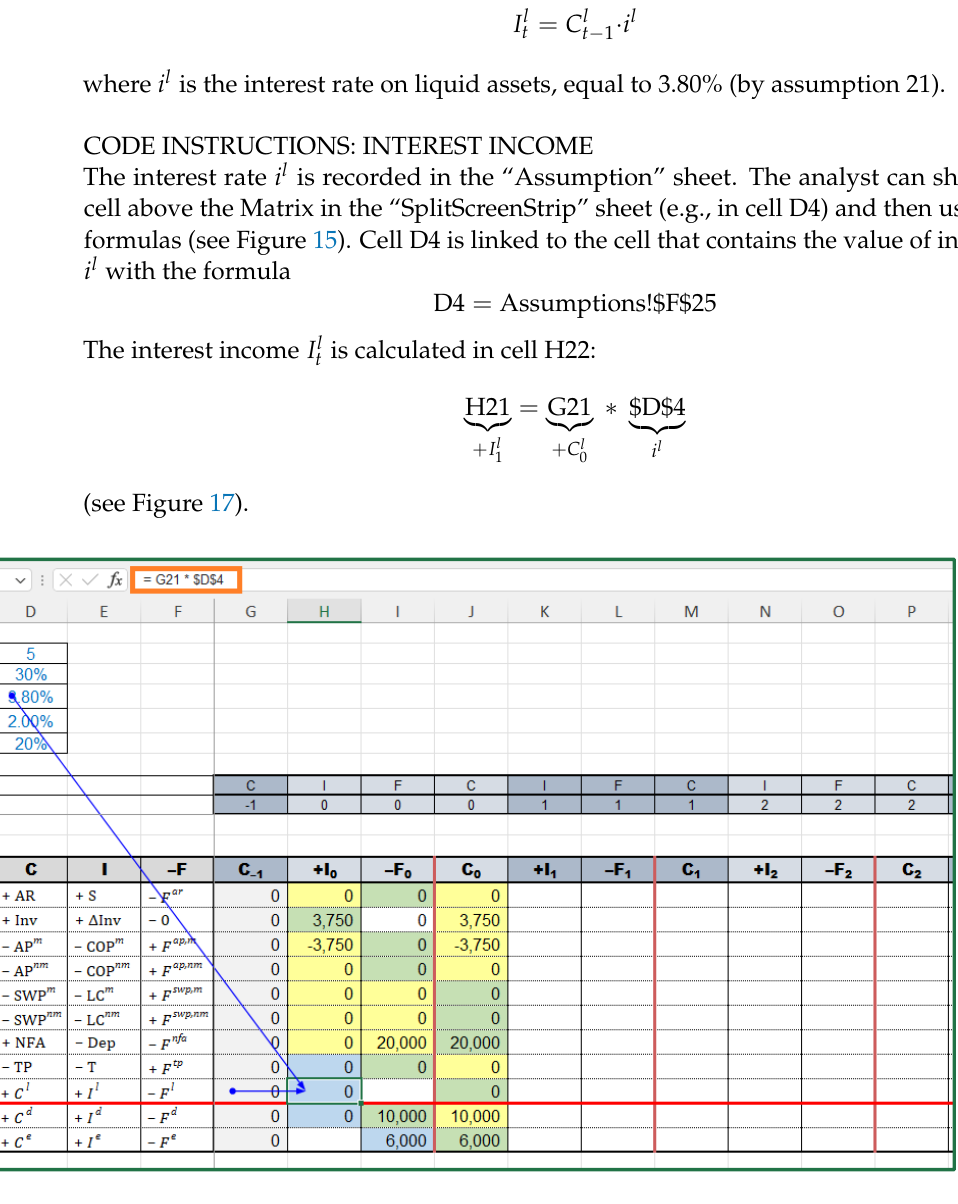
Figure 17. Cell H21 contains the specific formula for calculating the interest income (“SplitScreenStrip” sheet). (The cells whose values are provided in “PreCalc” are in yellow, the cells whose values are calculated with the law of motion are in green and the cells whose values are calculated via suitable formulas are in blue.)